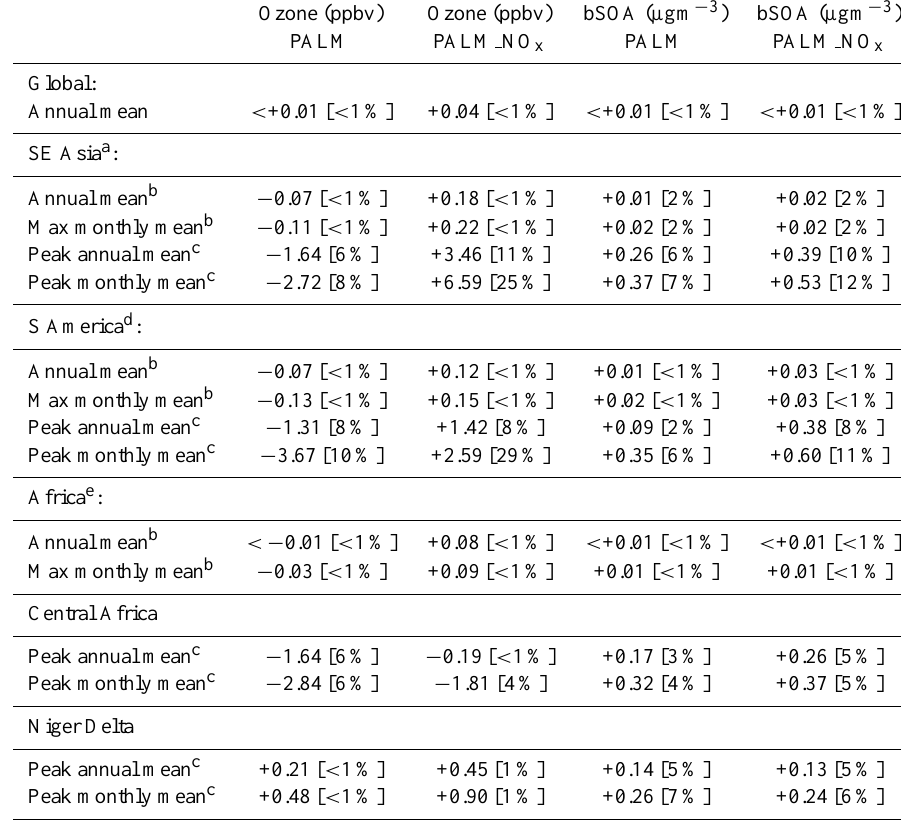
Table 2. Summary of changes in ground-level ozone and biogenic SOA concentrations for the oil palm